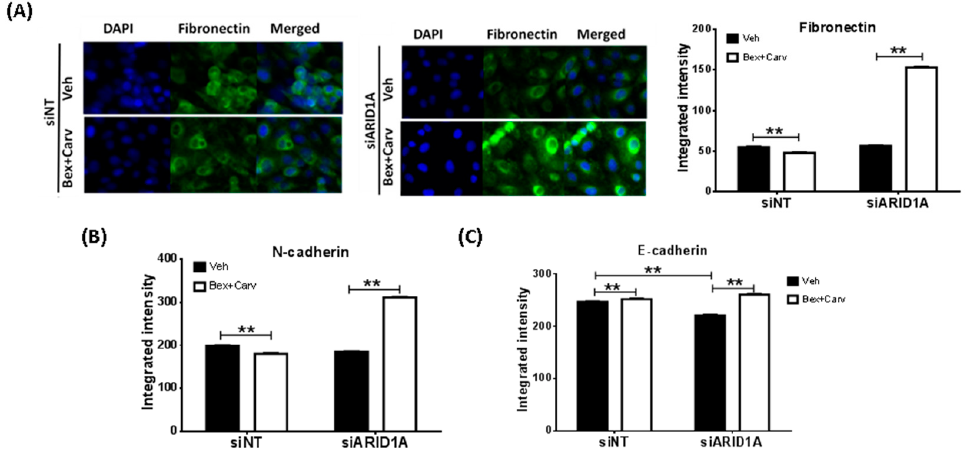
Figure 5. Comparison of the responses to Bex+Carv in EMT marker expression in control and ARID1A-silenced HME-hTert cells. ( A ) Representative images and quantification of cells transfected with siRNA against luciferase as a control (siNT) or ARID1A (siARID1A) for 72 h and treated with Veh or Bex (100 nmole/L) and Carv (1000 nmole/L) for 24 h and immunostained for Fibronectin-1. ( B , C ) Quantification of N-cadherin ( B ) and E-cadherin ( C ) protein expression levels upon siNT or siARID1A transfection for 72 h and 24 h of Veh or 100 nmole/L Bex+ 1000 nmole/L Carv treatment. A minimum of 500 cells were analyzed individually using CellProfiler for whole cell integrated intensity of Fibronectin, N-cadherin, or E-cadherin (20 × magnification). The results are expressed as mean ± SEM ** p < 0.01 by One-way ANOVA, Tukey post-hoc